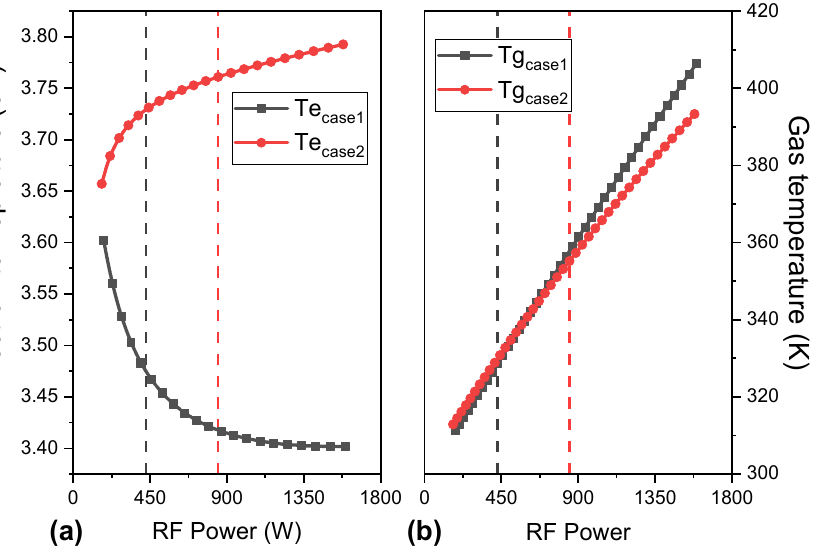
Figure 4. Electron temperature ( a ) and neutral gas temperature ( b ) as a function of RF power for the cases 1 and 2. Pressure = 2 cases 1 and 2. Pressure = 2 mTorr.